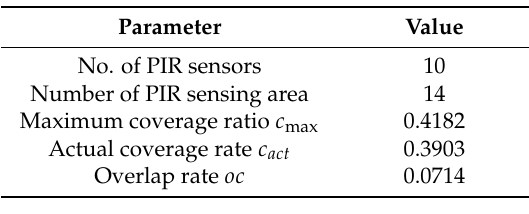
Table 1. PIR sensor parameters.